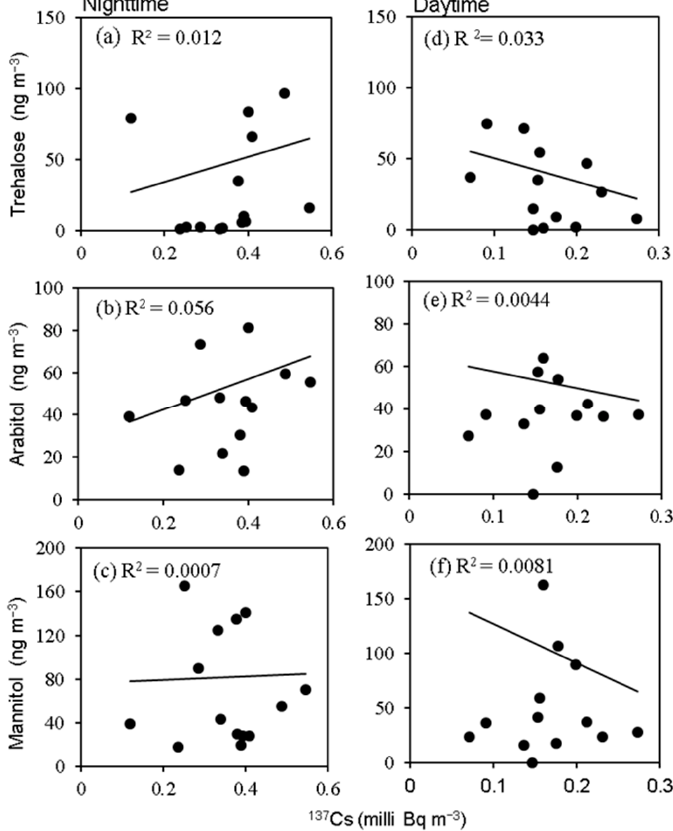
Figure 6. Correlations between organic tracers (arabitol, mannitol and trehalose) and 137 Cs in atmospheric aerosols collected in ( a – c ) night- and ( d – f ) daytime periods from Fukushima, Japan. Table 2. Sugar compounds detected in water-extracts from fungal spore (171012 Fungi,